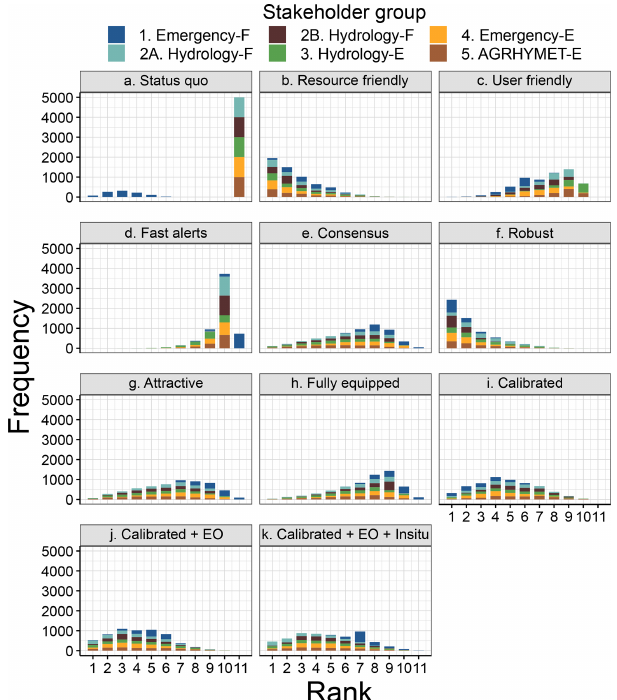
Figure 6. Ranks of 11 FEWS configurations, including uncertainty of expert predictions. Frequency ( y axis): how often each FEWS (blocks, a. Status quo , b. Resource friendly , etc.) achieved a rank (1: best rank, 11: worst; x axis) in each model run for each stakeholder group (stacked bars); 1000 Monte Carlo simulation runs drawing from uncertainty distributions of attribute predictions.